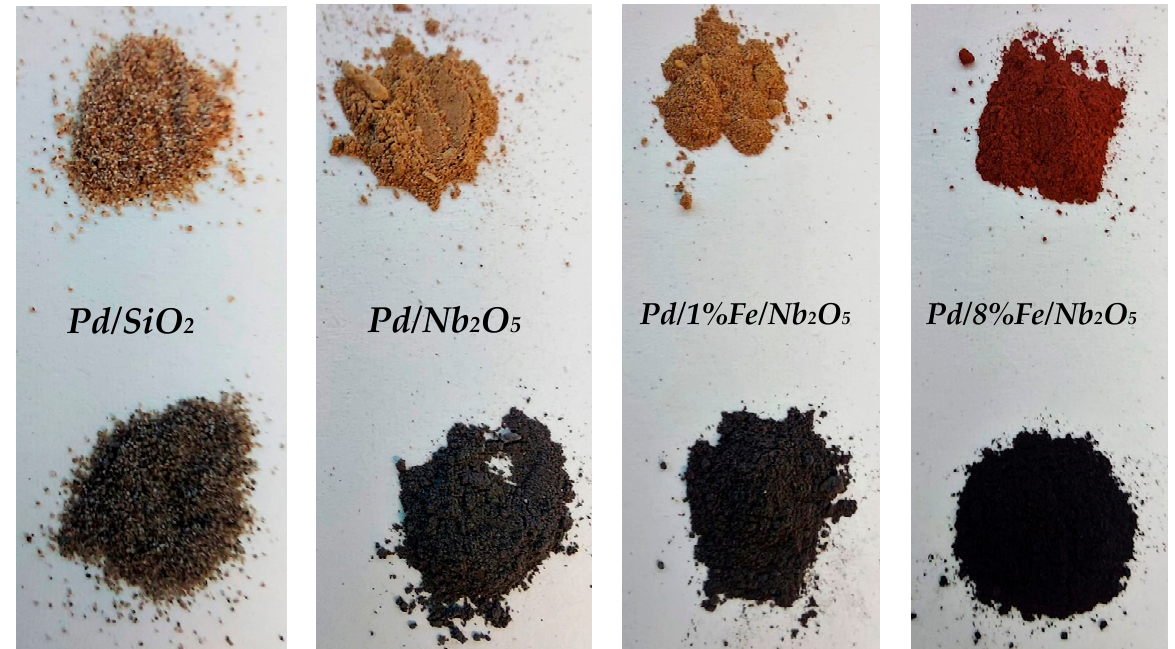
Figure 15. Appearance of synthesized catalysts after calcination (top) and after reduction (bottom). The color change indicates the reduction of hematite (Fe 2 O 3 ) typically red to Fe and Fe 3 O 4 (grey).